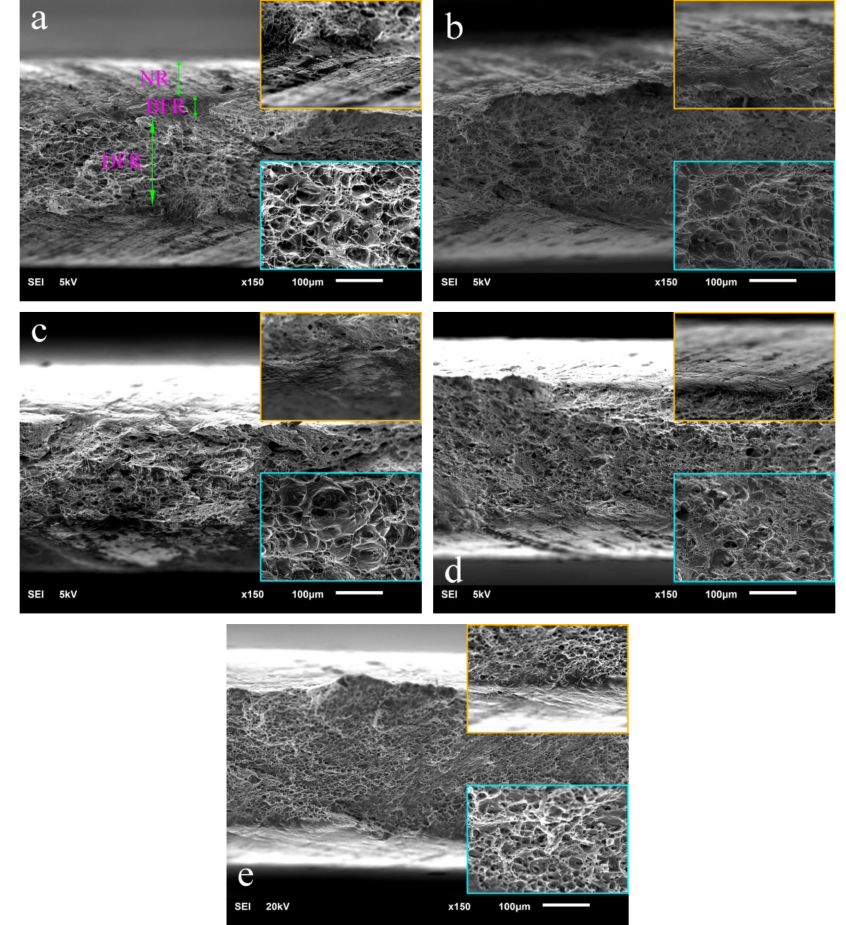
Figure 8. Fracture morphology of cold-rolled 5052 aluminum alloys with embedded graphs to reflect the local characteristics on the right of images observed via SEM: ( a ) A0 without Er; ( b ) A1 with 0.1% Er; ( c ) A2 with 0.2% Er; ( d ) A3 with 0.4% Er and ( e ) A4 with 0.8%